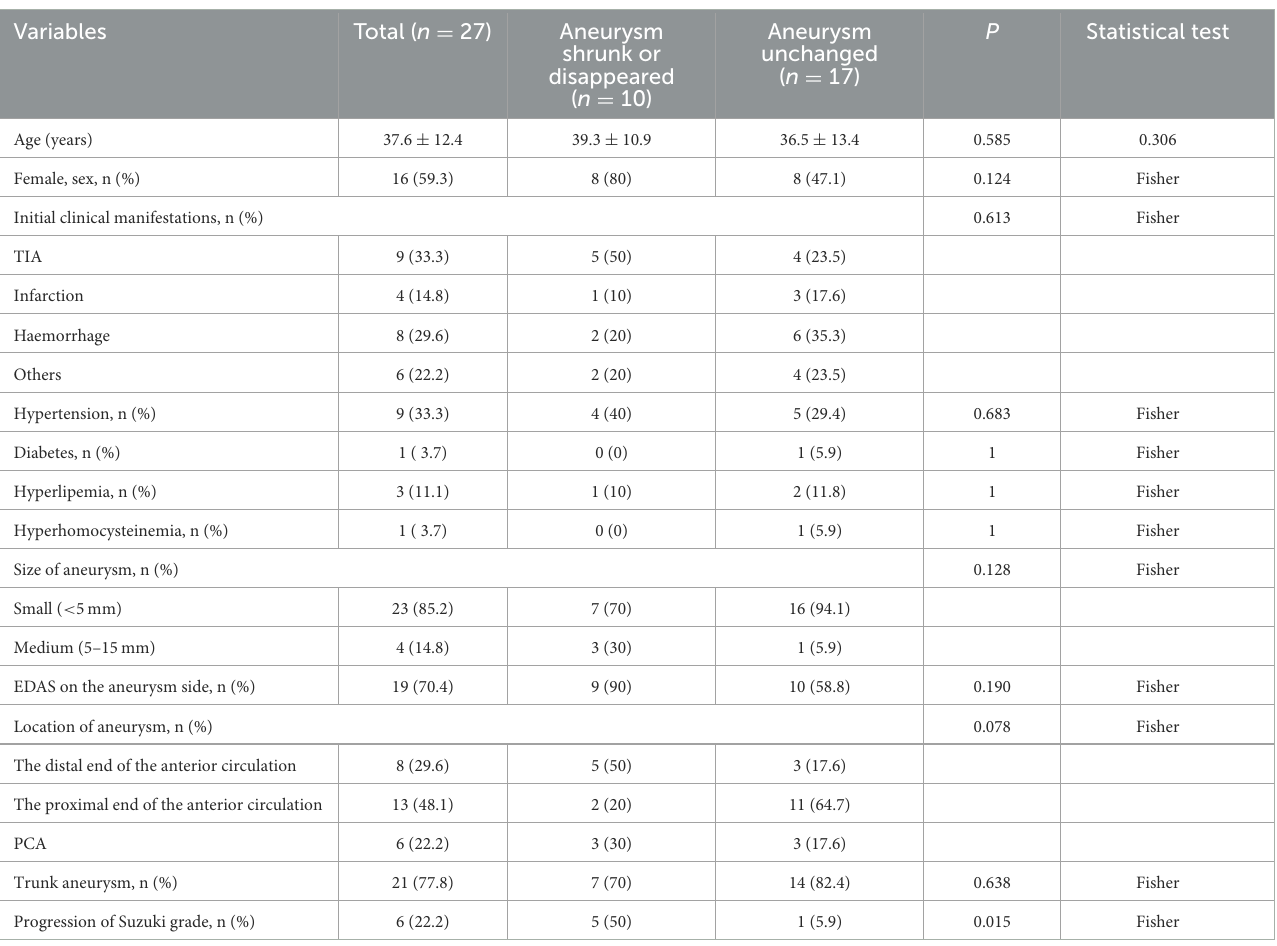
TABLE 2 Characteristics of 27 MMD patients with intracranial aneurysms on follow-up.